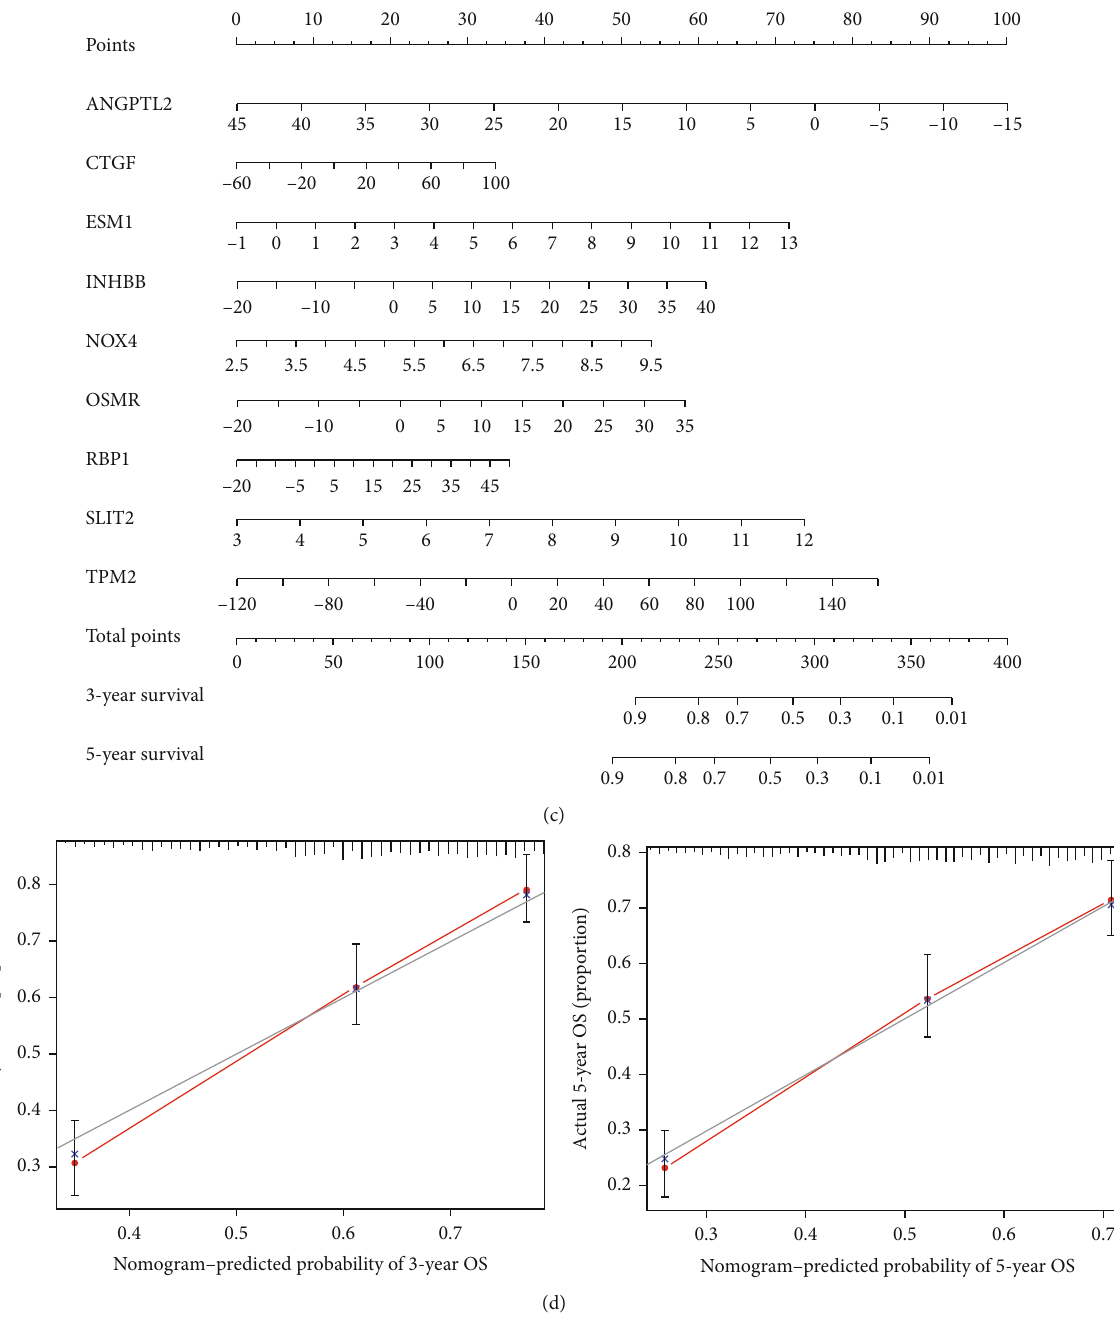
Figure 2: Construction of a nine-gene prognostic signature. (a, b) Kaplan – Meier survival analysis and time-dependent ROC analysis regarding risk score and OS in the training cohort. (c, d) Prognostic signature visualized as a nomogram and tested by the calibration